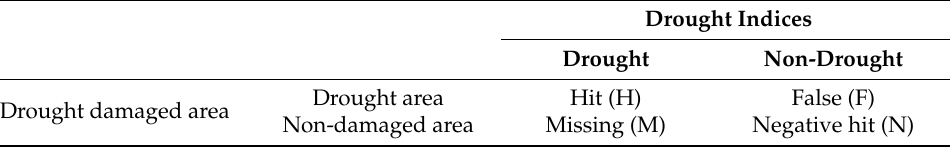
Table 5. Confusion matrix of ROC Analysis.